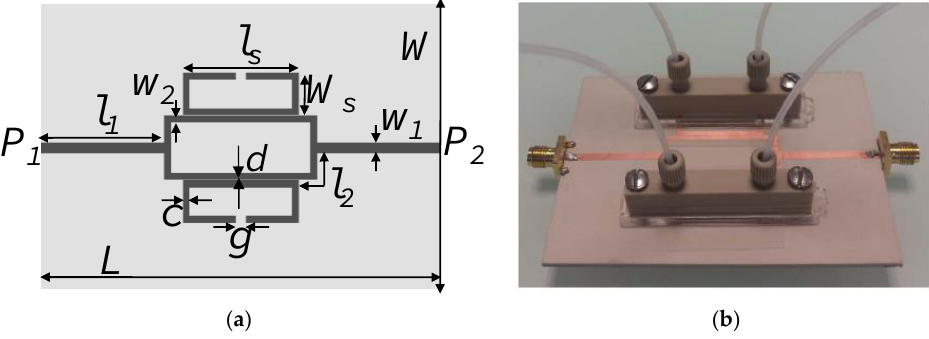
Figure 22. Layout ( a ) and perspective view ( b ) of the designed frequency-splitting sensor. From [58], reprinted with permission.